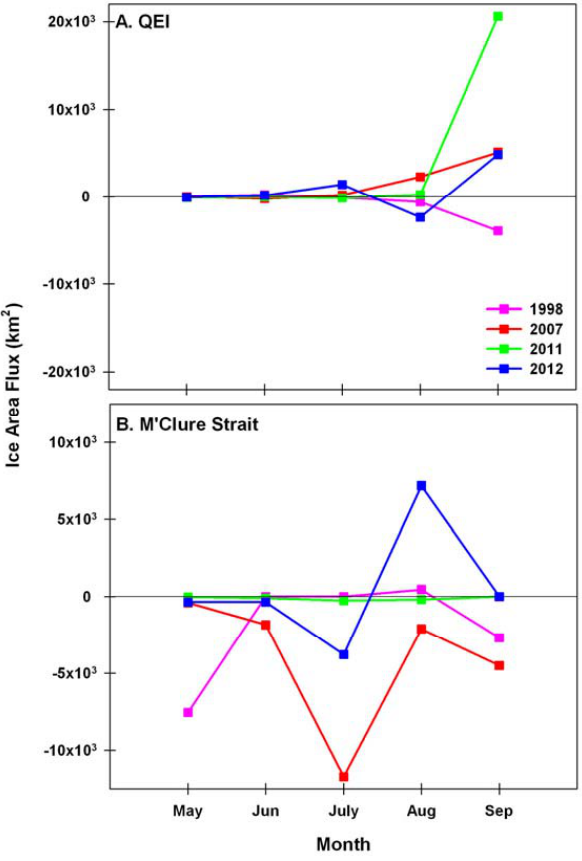
Figure 11. Time series of mean May to September Arctic Ocean-Canadian Arctic Archipelago Fig. 11. Time series of mean May to September Arctic Ocean– sea ice area flux (km 2 ) at the Queen Elizabeth Islands (QEI) (A) and the M’Clure Strait (B) for Canadian Arctic Archipelago sea ice area flux (km 2 ) at the 1998, 2007, 2011 and 2012 estimated from RADARSAT. Positive/negative sign indicates Arctic Queen Elizabeth Islands (QEI) (A) and the M’Clure Strait (B) for Ocean inflow/outflow. 1998, 2007, 2011 and 2012, estimated from RADARSAT. Posi- tive/negative sign indicates Arctic Ocean